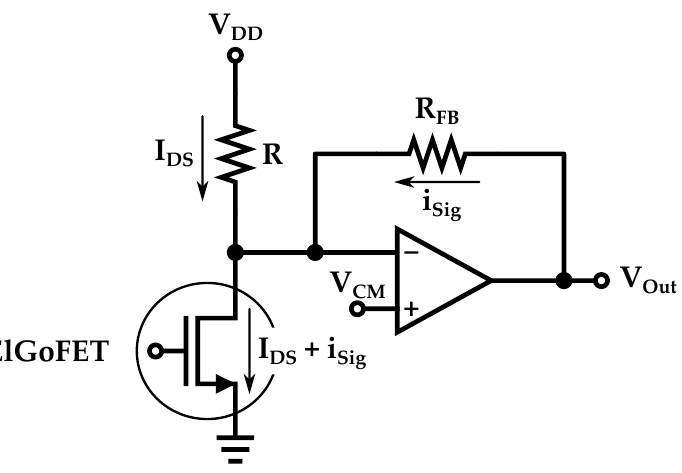
Figure 14. Schematic representation of the pre-amp circuit used as readout for an ElGoFET MEMS microphone. V DD is the supply voltage, I DS is the bias drain-to-source current of the FET device while i sig is the signal